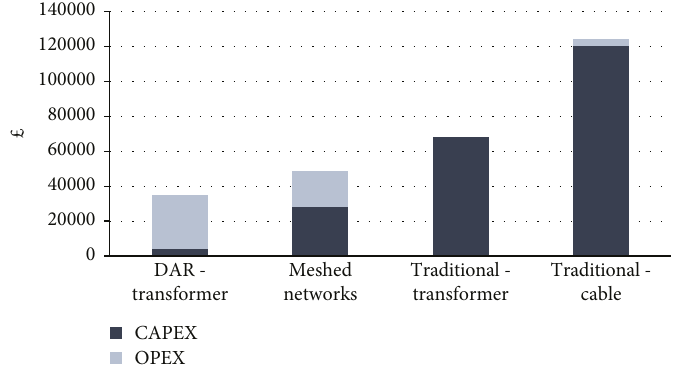
Figure 15: Average cost disaggregation per technique; DECC2, 2015 – 2023.